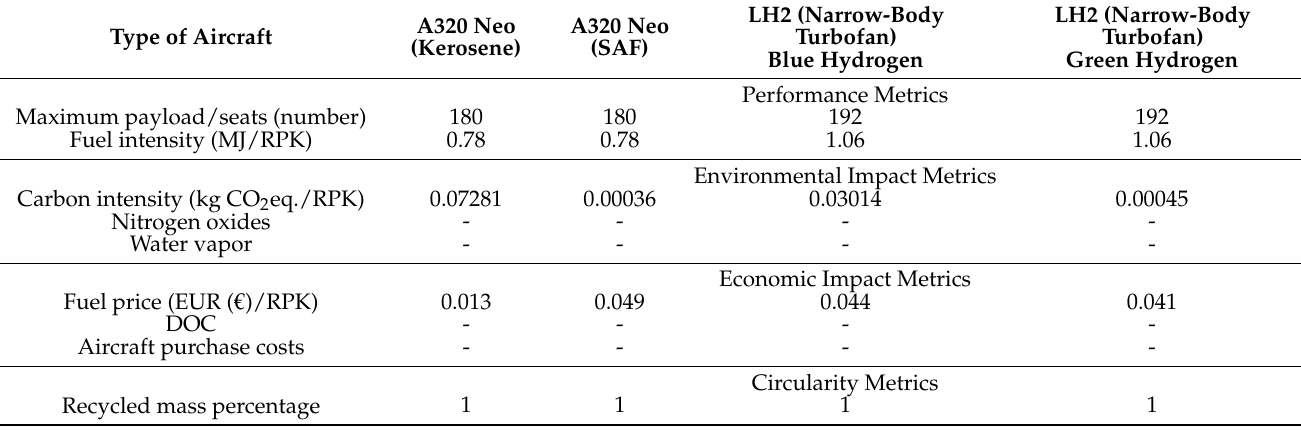
Table 2. Investigated aircraft and metrics considered for aircraft sustainability